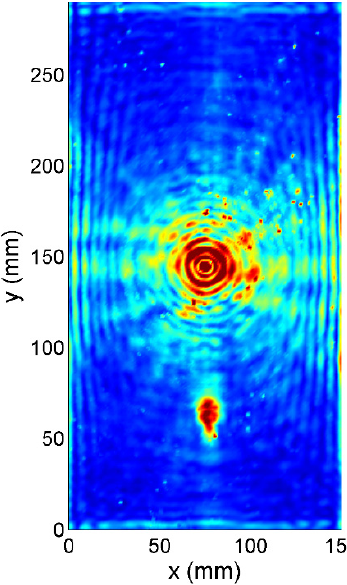
Figure 8. The energy of abnormalities in propagating Lamb waves map.